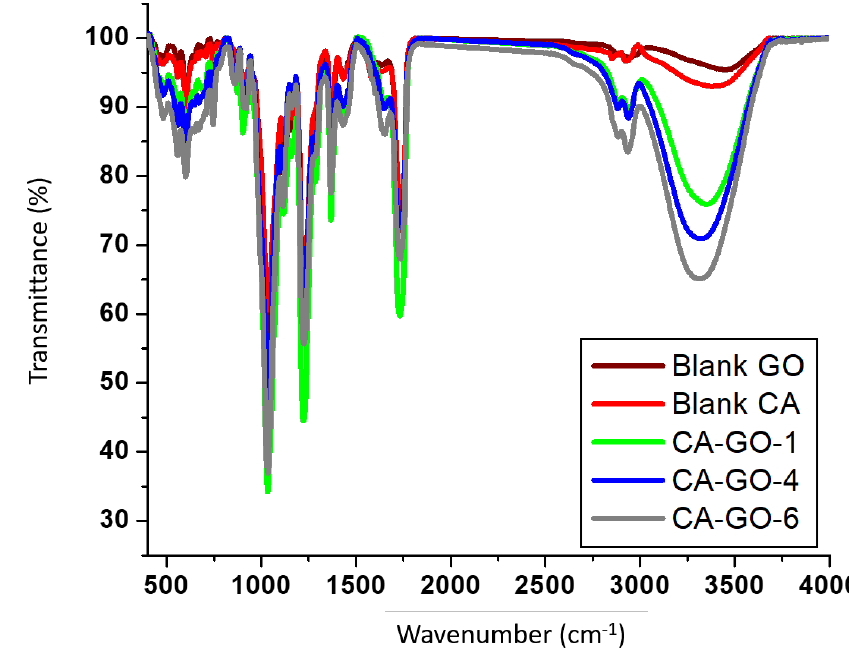
Figure 2. FTIR spectra of graphene oxide powder, blank cellulose acetate film (CA-GO-0), and CA-GO films at lowest total content of GO (CA-GO-1), medium total content of GO (CA-GO-4), and highest total content of GO (CA-GO-6).